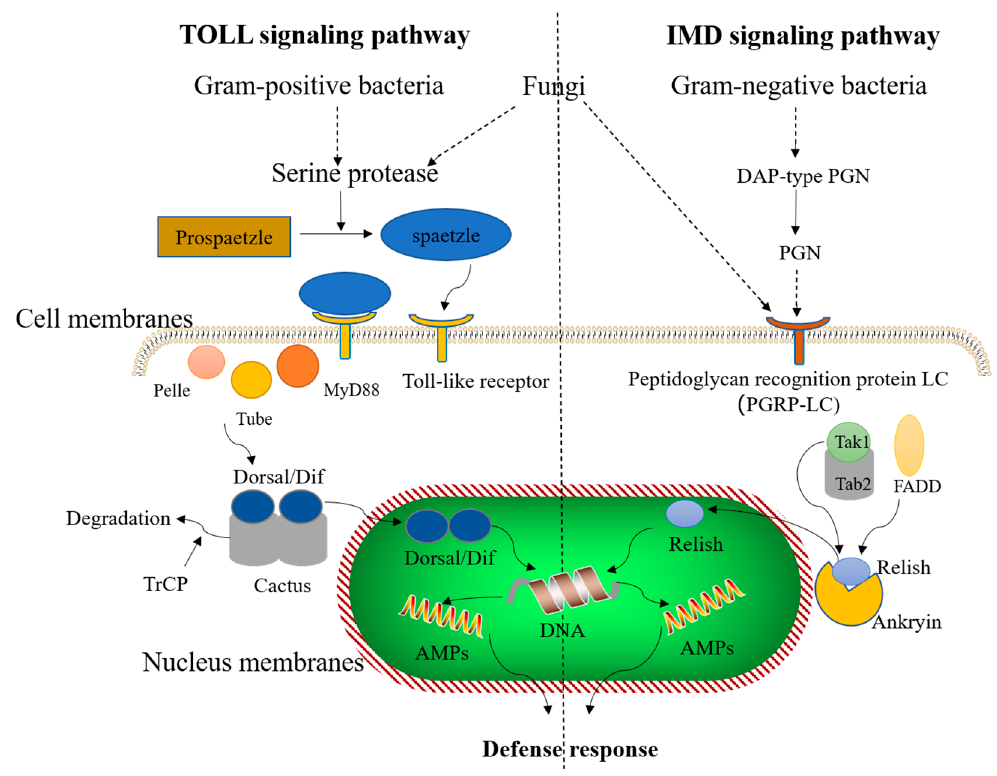
Figure 2. The immune-induced signaling pathway of insect antimicrobial peptides (AMPs). The Toll signaling pathway is activated by Gram-positive bacteria and fungi, and the immune deficiency (IMD) signaling pathway is activated by Gram-negative bacteria and fungi. These two signaling pathways act independently and AMP production is induced by transport of a series of necessary proteins into the nucleus.